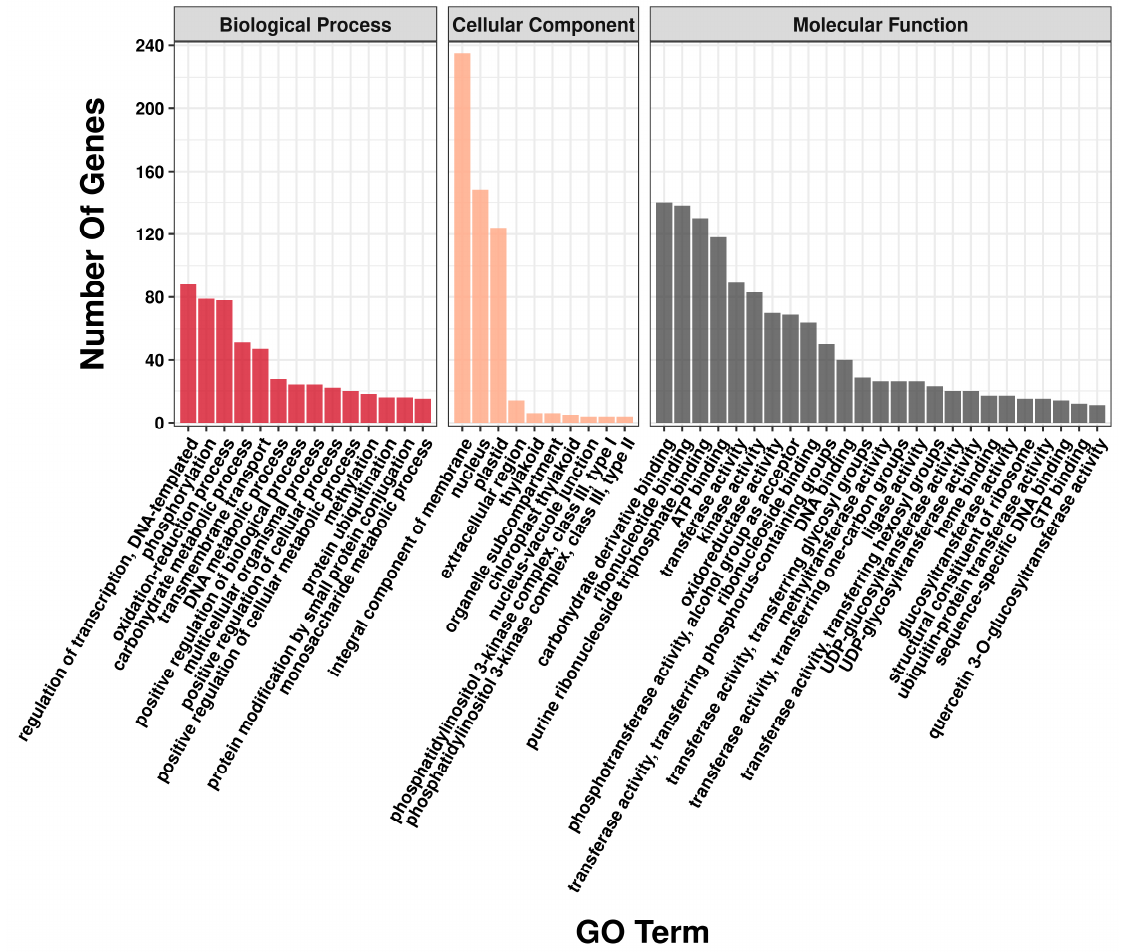
Figure 3. Analysis of 885 DEGs enriched for GO terms in